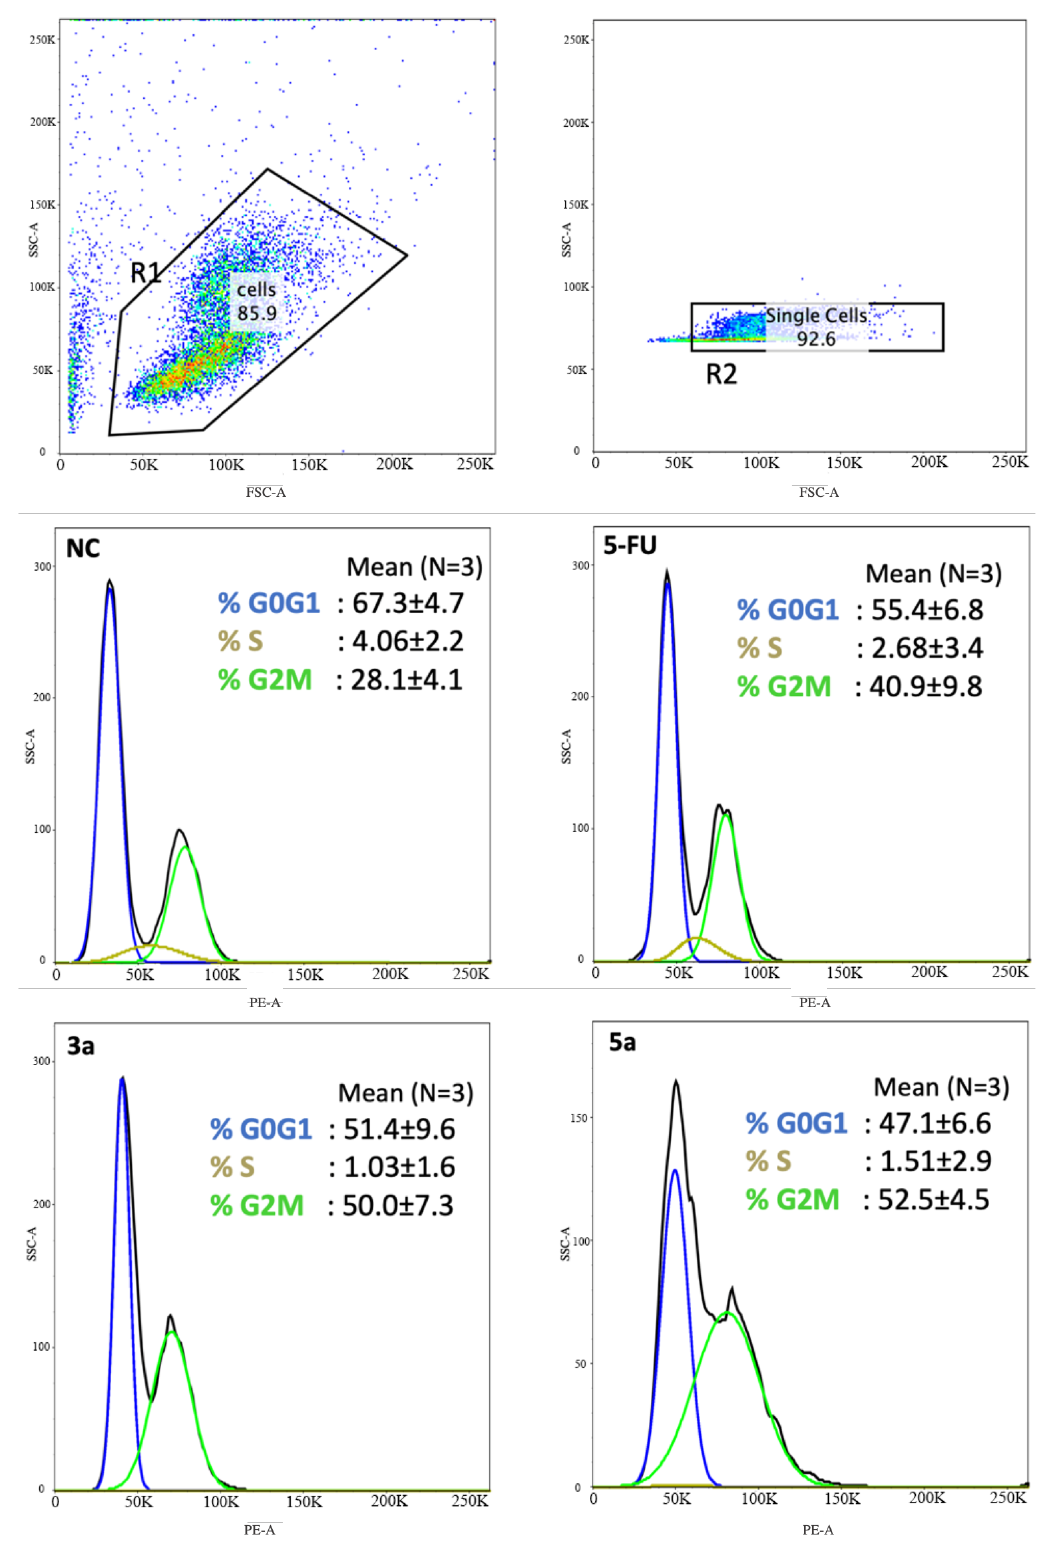
Figure 4. Chalcone methoxy derivatives induce cell cycle arrest in Luc-4T1 cells. Cells were treated for 24 h with 20 μg/mL of compound 3a , compound 3c , 5-FU as a positive control, or untreated as controls (NC). The cells were then harvested, fixed in 70% ethanol, and stained with PI for FACS analysis. The percentage of cells in each phase of the cell cycle was shown as mean ± SD over the histograms. Two independent experiments were performed. NC; non-treated cells.